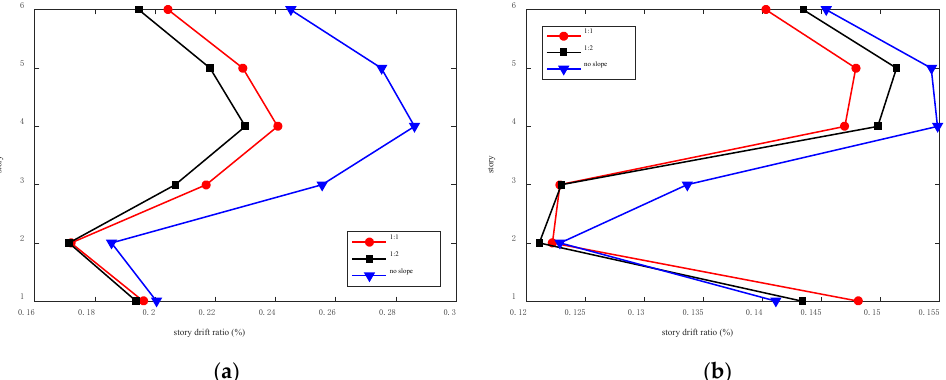
Figure 8. Inter-story displacement angle of each structure: ( a ) working condition 6; ( b ) working condition 18.